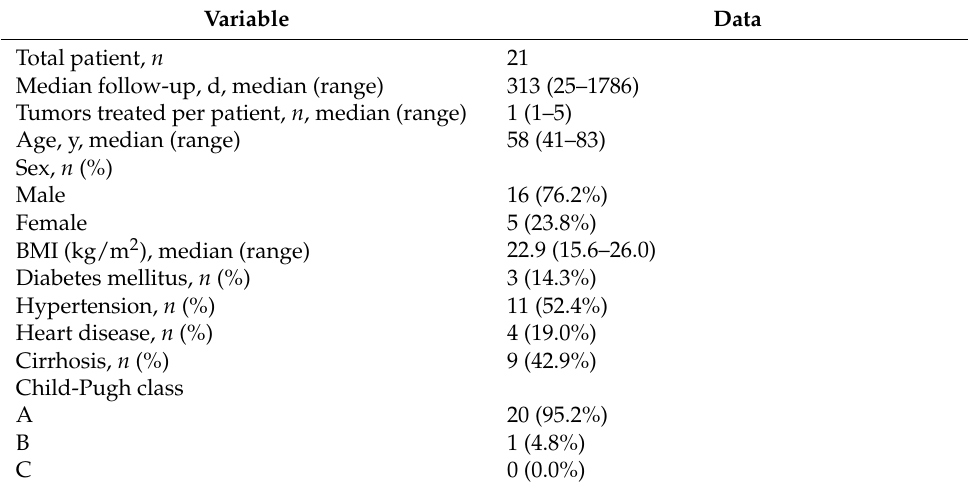
Table 1. Patient